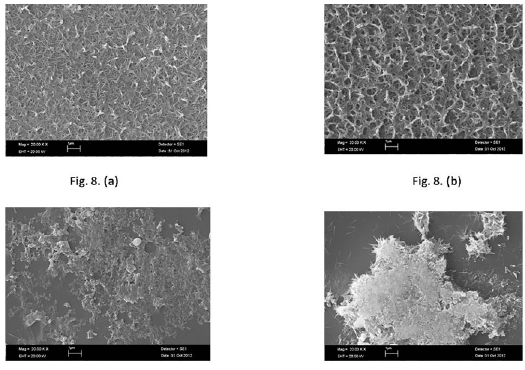
Figure 8. SEM images of MnSe films at different pHs, (a) pH = 8, (b) pH = 9, (c) pH = 10, (d) pH =